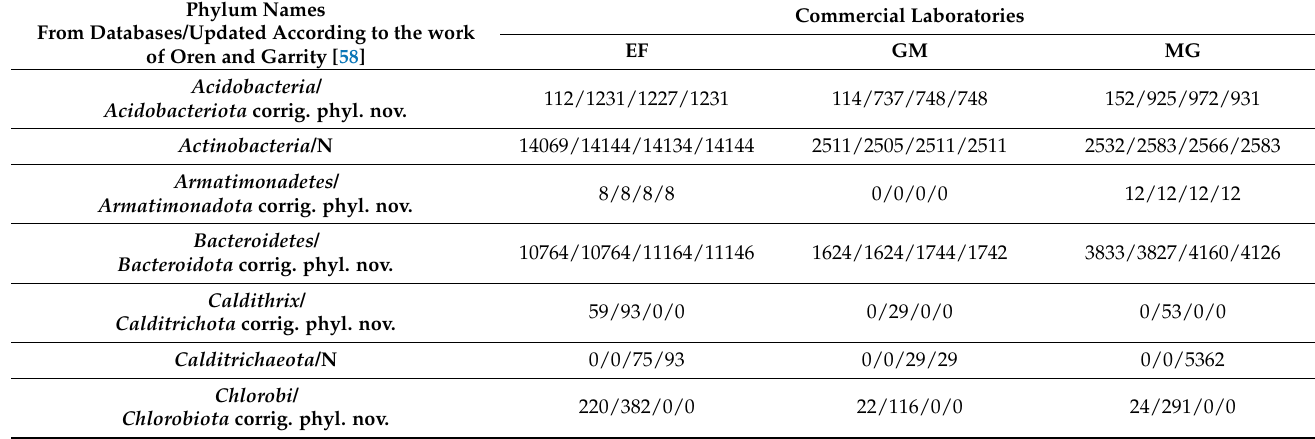
Table 5. Classification rate summary (at least 97% sequence similarity) of the 16S rRNA metagenetic library at phylum level based on the following databases: Greengenes 515–806 / Greengenes full-ref- erence / SILVA 515–806 / SILVA full-reference. Abbreviations: N—not available . Phylum Names From Databases/Updated Accord- ing to the work of Oren and Gar- rity [58]